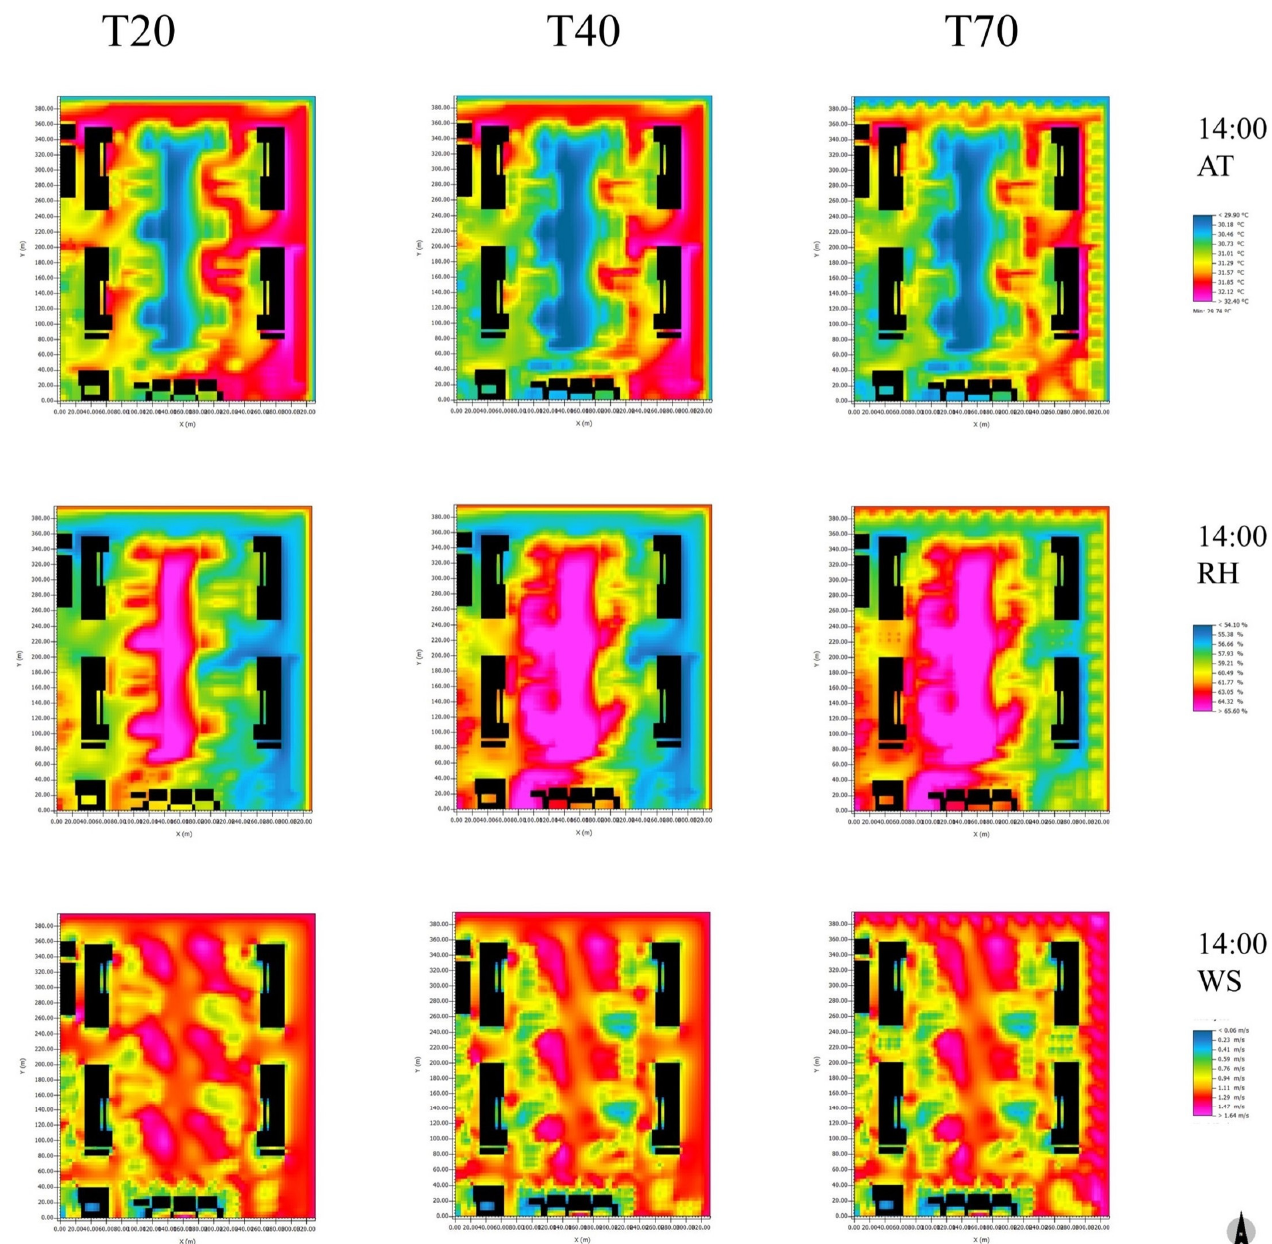
Figure 8. Distribution maps of microclimate parameters at 14:00 with redesigned vegetation